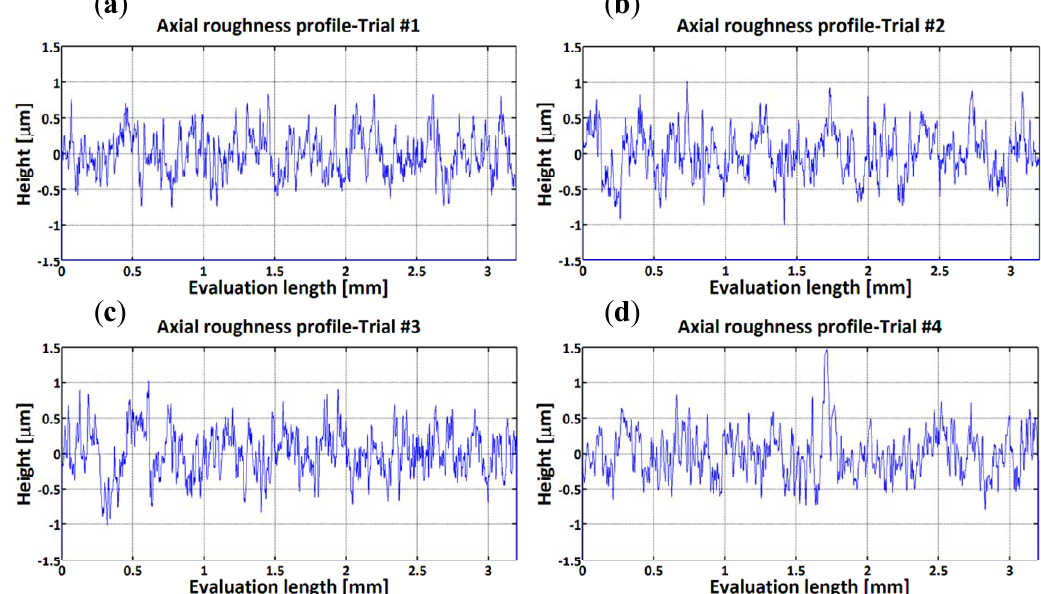
Figure 1. Examples of surface roughness profiles in axial direction: ( a ) Trial